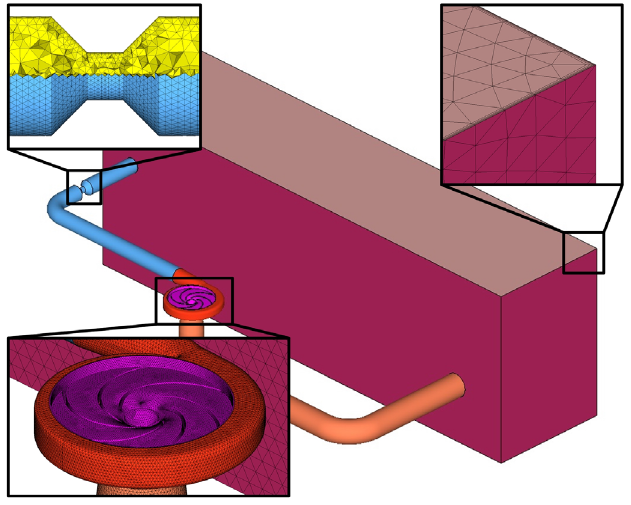
Fig. 4. Calculation grid of semi-enclosed centrifugal pump piping